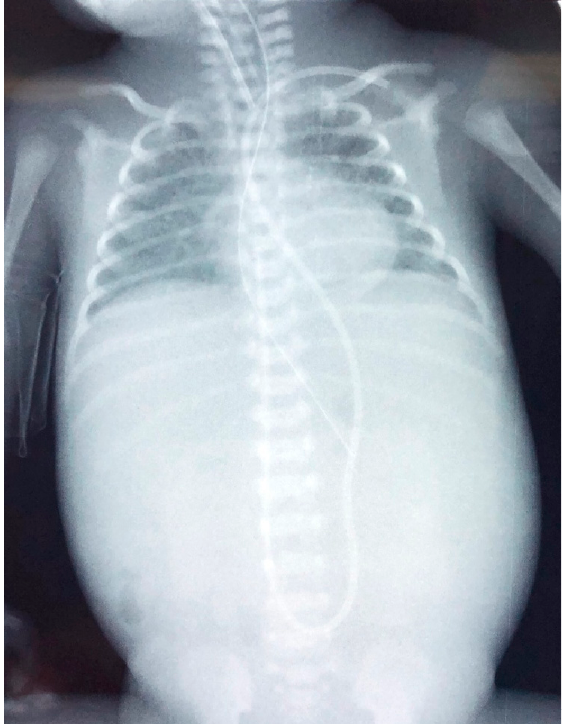
Figure 6. Radiography of the infant on the day of deterioration, with non-specific signal characteristics in abdomen, such as distended abdomen and poor distribution of bowel gas.